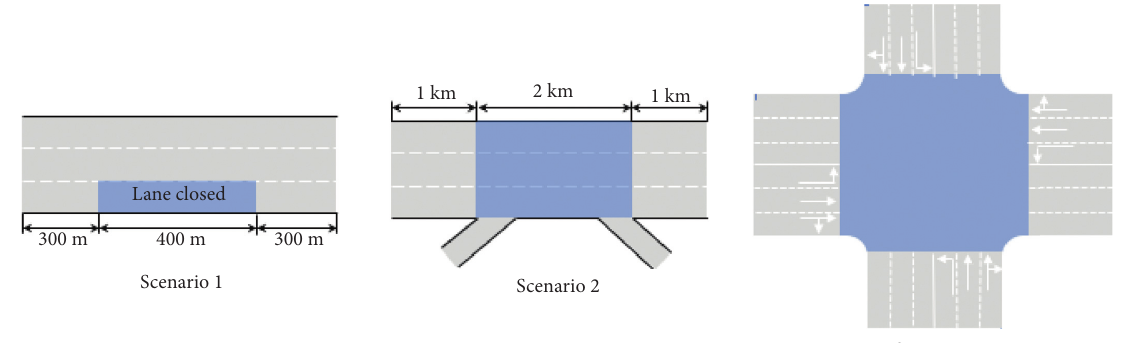
Figure 4: The schematic diagrams of the three traffic